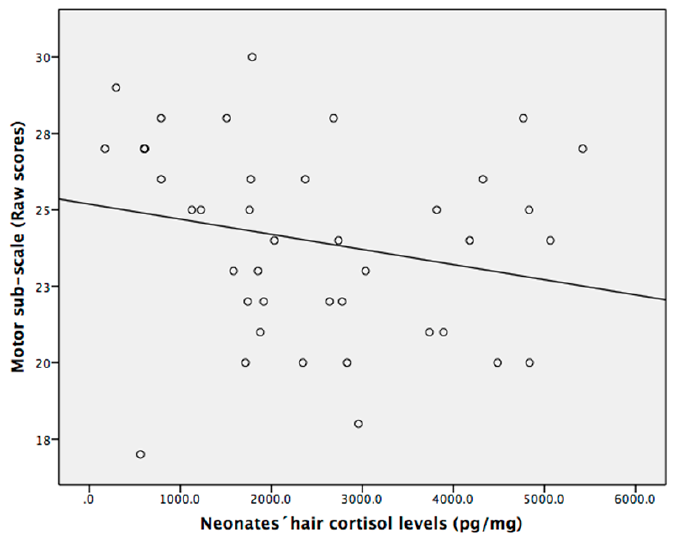
Figure 2. Higher neonatal hair cortisol levels predicted low development in infants. Hair cortisol levels and motor development are raw data.